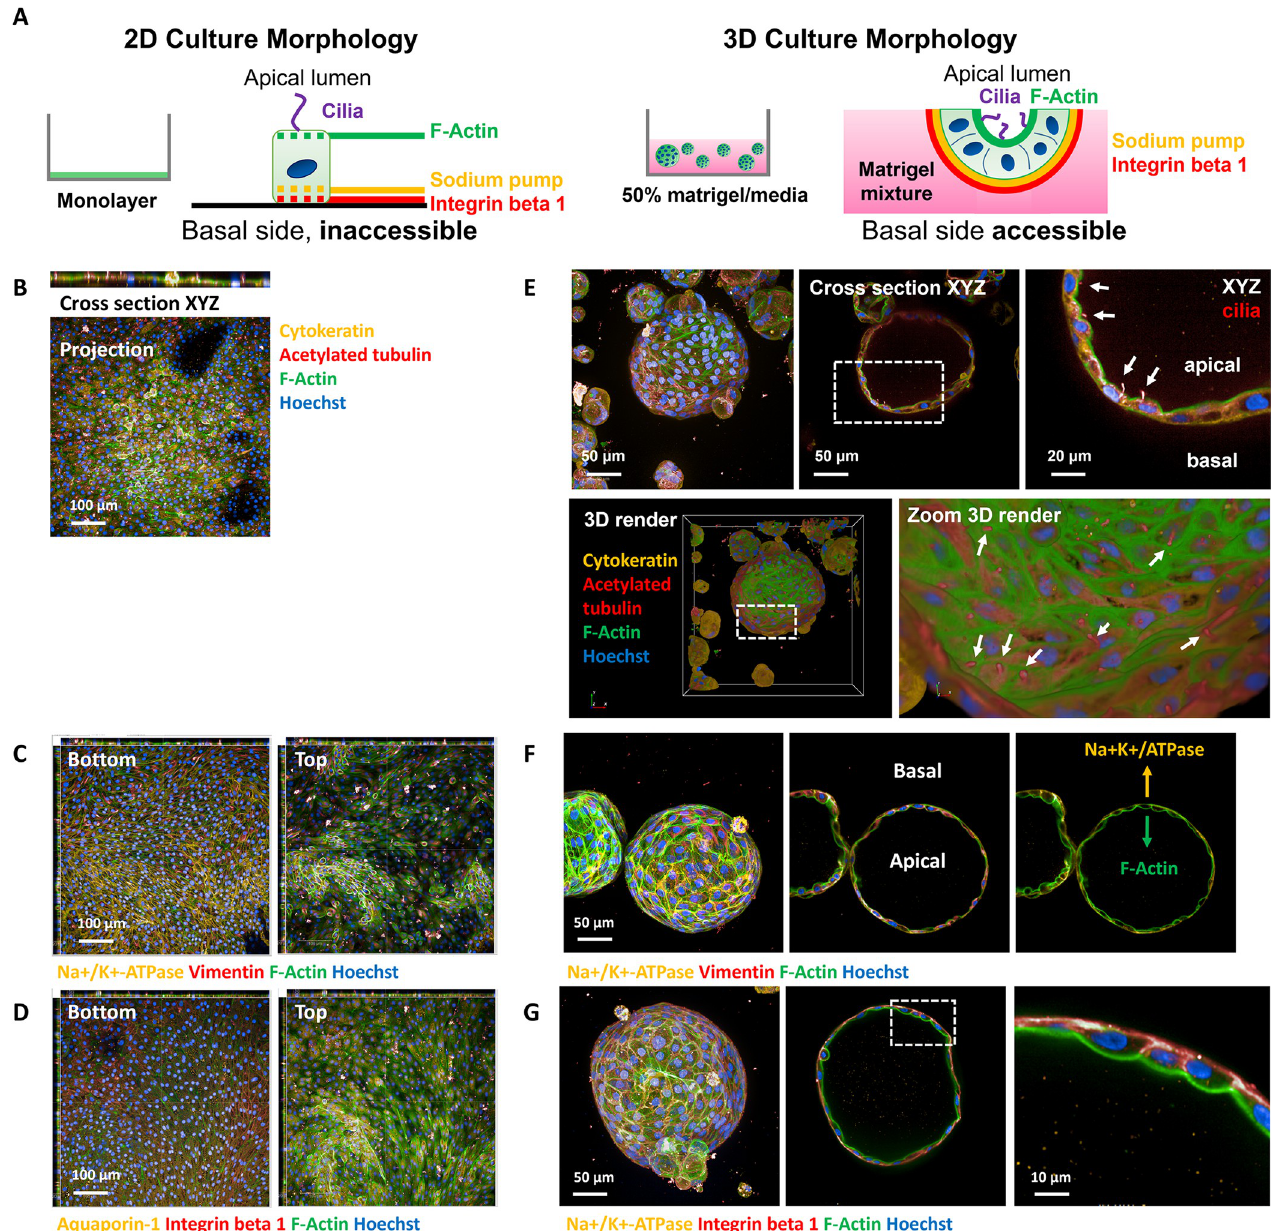
Fig 2. Differences between 2D and 3D culture method. (A, D) In 2D, cilia are present, pointing upwards into the well and are susceptible directly to toxin addition whereas in 3D, the cilia are facing the apical lumen of the tubuloid (white arrows). (B, E) A key transporter (Na+/K+-ATPase) is basolaterally expressed, whereas in 2D while also basal is inaccessible against tissue-culture plastic. (C, F) Similarly, integrin-beta 1 is basolaterally expressed in 3D and 2D, however the 2D basal side is inaccessible whereas in 3D it is